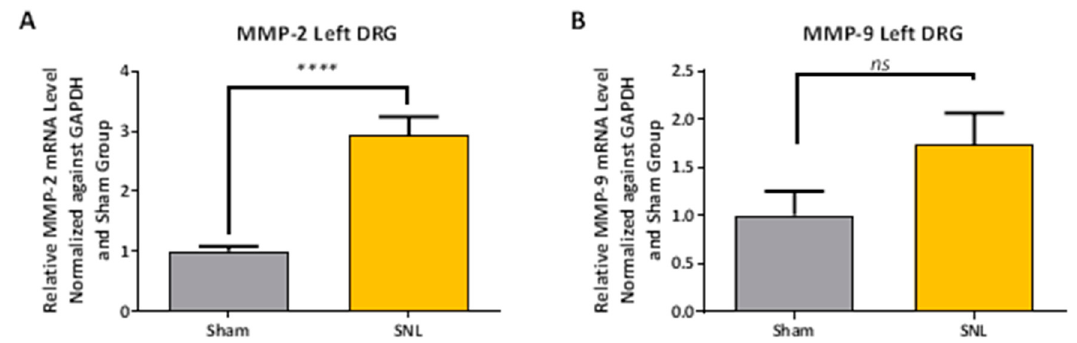
Figure 2. Mechanical Response Threshold: Spinal Nerve Ligation (SNL) Chung Model (Chung), Contralateral (Contra) Paw Withdrawal. Contralateral paw withdrawal thresholds following surgery and administration of AQU-118. Data are presented as mean ± SEM.